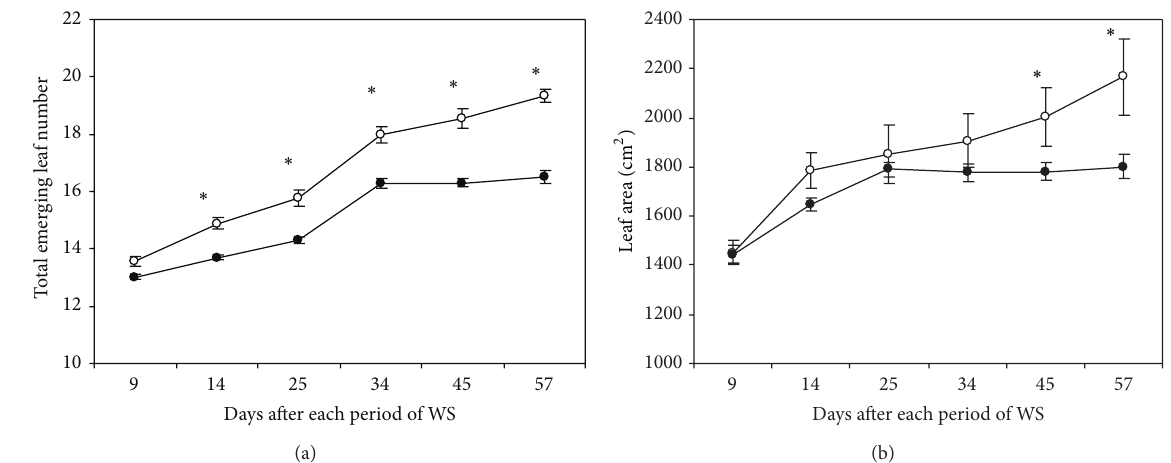
Figure 3: Total emerging leaf number (a) and leaf area (b) determined in regularly irrigated ( I ) and water-stressed ( e ) banana plants. Data are means ± SE and each value was determined in three different plants with three replicates per treatment ( 𝑛 = 9 ). Data were compared for each date using the least significant difference (LSD) test. Significant differences at 𝑃 ≤ 0.05 are represented by an asterisk ( ∗ ). WS: water stress.